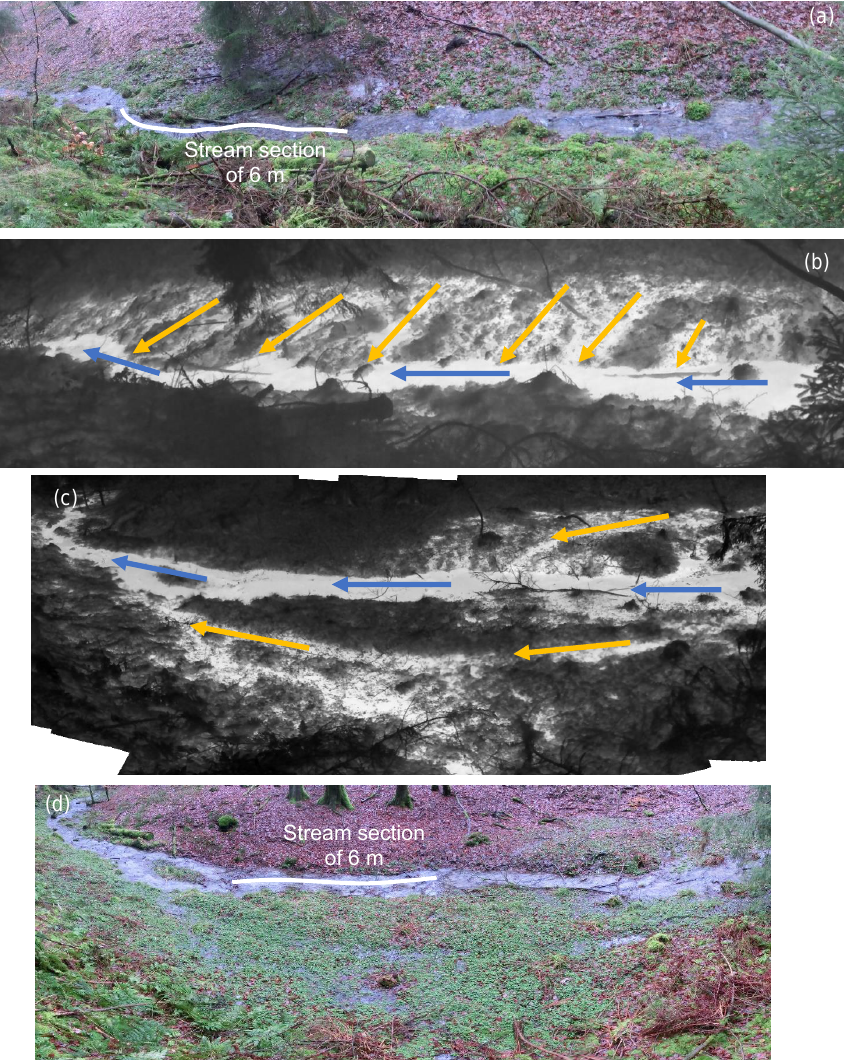
Figure 5. Comparison of different types of surface-saturation patterns. The yellow arrows indicate the orientation of the saturated areas towards the stream (blue arrows represent flow direction). The perpendicular direction (a, b) is likely caused by exfiltrating groundwater connecting to the stream, and the parallel direction (c, d) is likely caused by a parallel flow of the stream expanding into the riparian zone. The red ovals indicate where the two panorama images